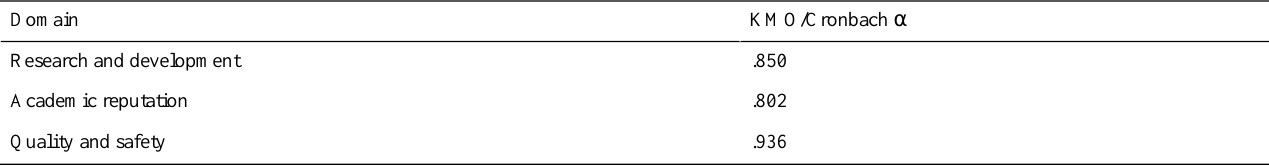
KMO/Cronbach α Domain